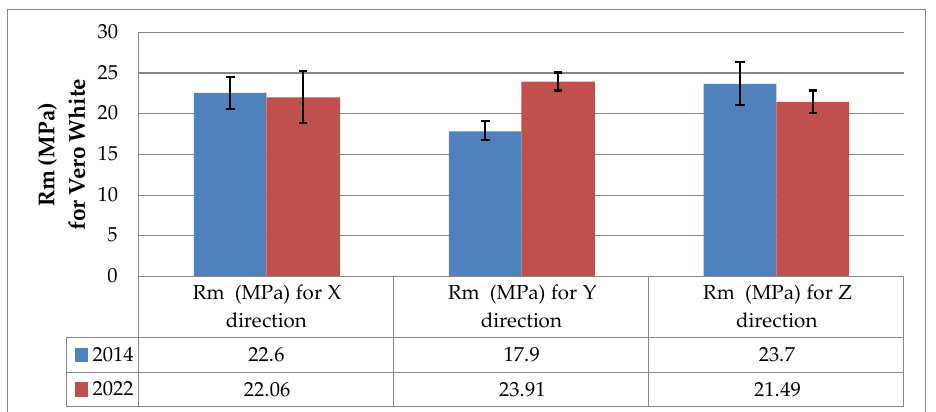
Figure 4. Tensile strength R m of the as-printed (December 2013) and naturally aged (July 2022) specimens based on FullCure 720 resin.